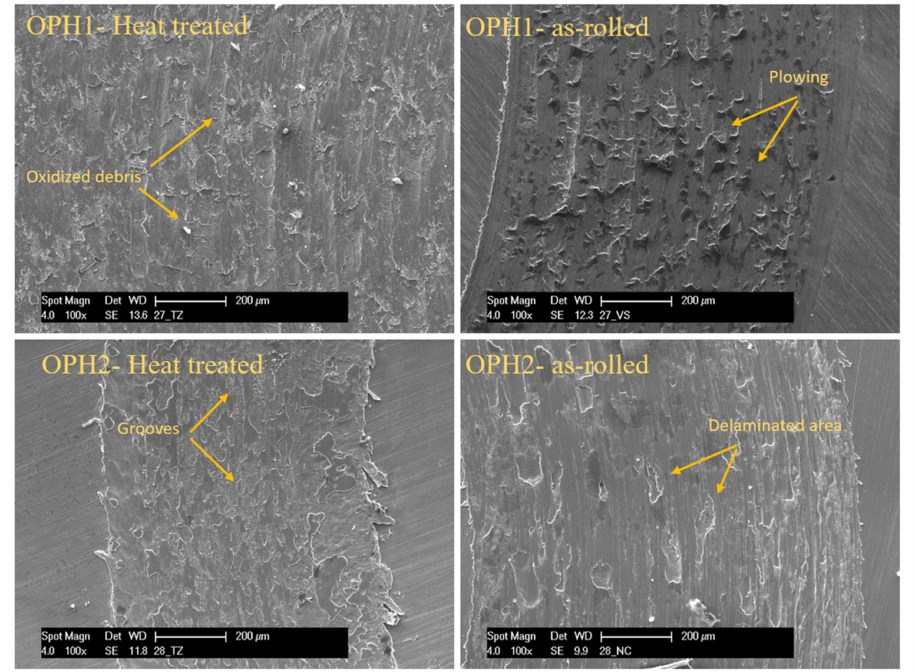
Figure 12. SEM images of wear tracks on the surface after the pin-on-disc test for OPH1 and OPH2 before and after heat treatment.